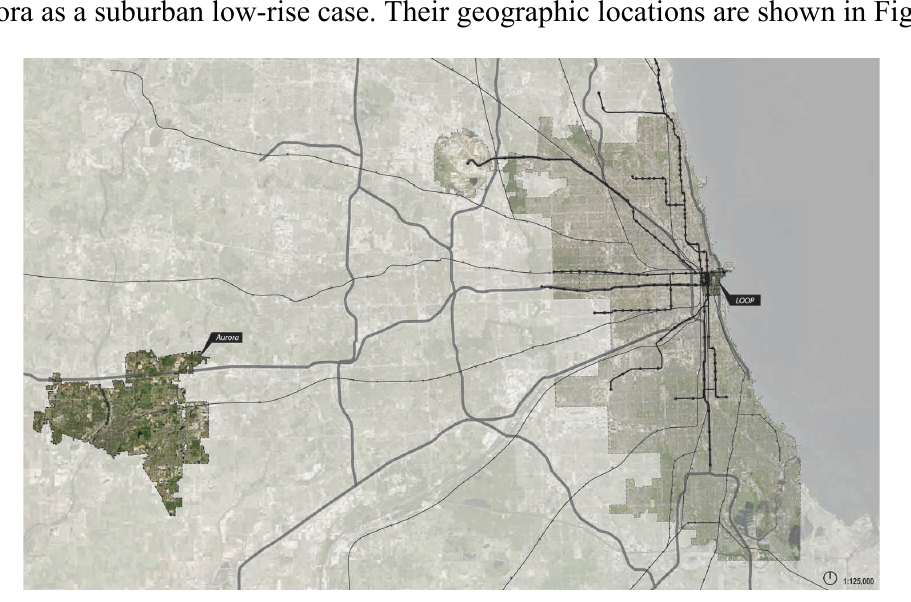
Figure 1. Site locations and transportation systems including Chicago Transit Authority (CTA) train lines, Metra lines, and major